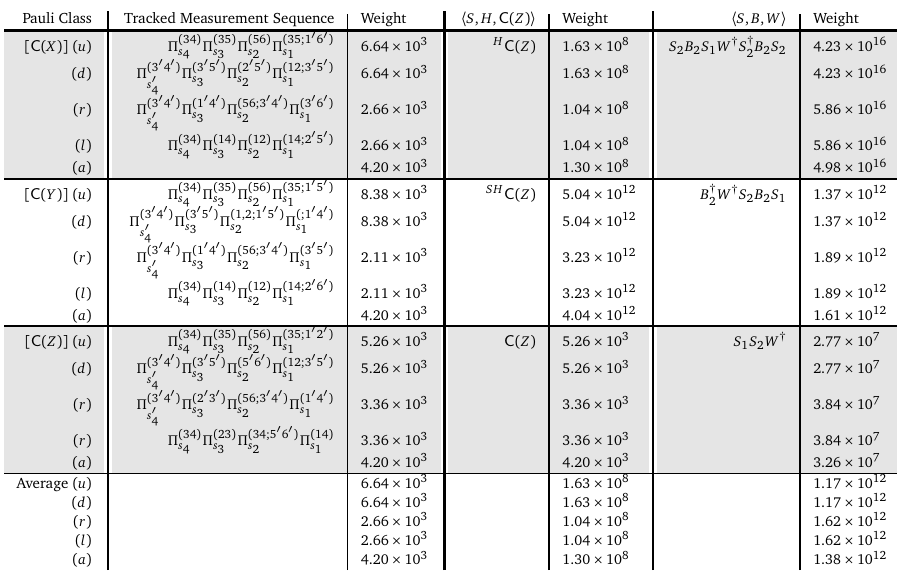
Table 9: Minimal difficulty weight measurement sequences for Pauli cosets of controlled-Pauli two-qubit gates when using Majorana-Pauli tracking methods. The labels ( u ) , ( d ) , ( r ) , and ( l ) indicates that for a hexon acting as the control qubit of the C ( P ) gate, the corresponding target qubit is the nearest neighbor hexon in the up, down, right, and left direction, respectively. Notice that the choice of control and target qubit is arbitrary for C ( Z ) , so ( u ) and ( d ) are re- lated by symmetry, as are ( r ) , and ( l ) . The average difficulty weight of the four directions is labeled by ( a ) . For comparison, we also present the corresponding realization of the gates formed by using the generating gate sets 〈 S , H , C ( Z ) 〉 and 〈 S , B , W 〉 . A C ( Z ) = A C ( Z ) A † denotes conjugation of C ( Z ) by A on the target 2 2